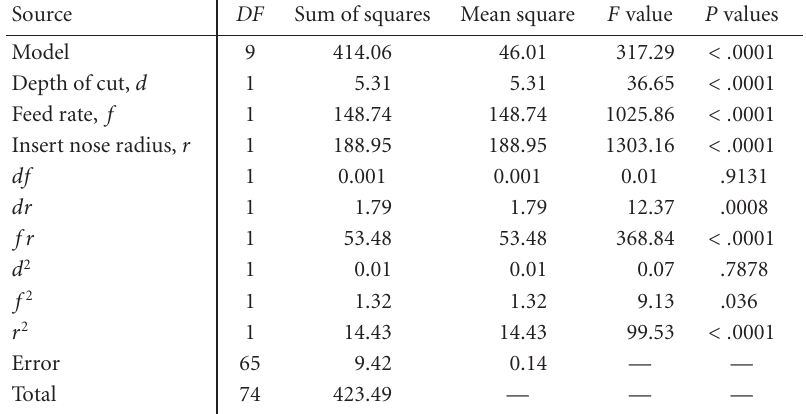
Table 9: Analysis of variance for surface roughness quadratic model in turning of AISI 1030 using cemented carbide tools.